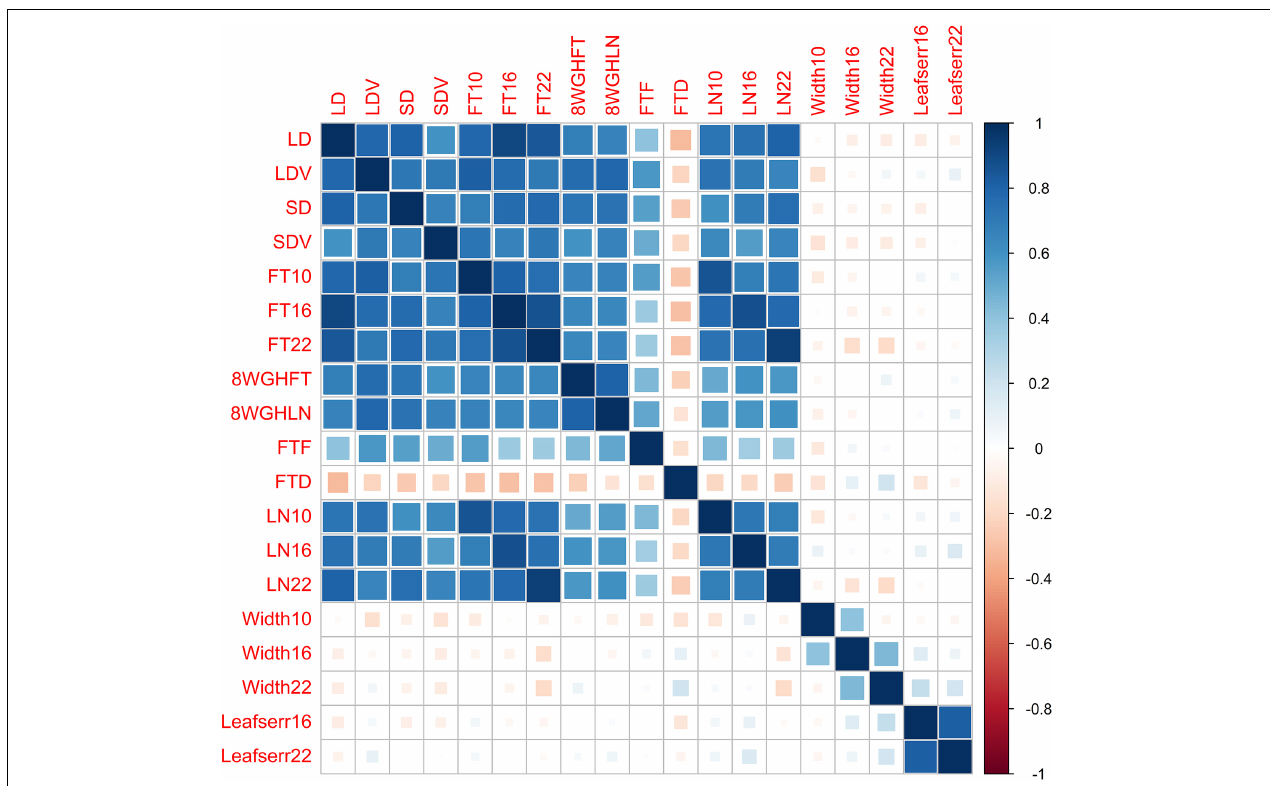
FIGURE 2 | Genetic correlations between 19 phenotypes in the Arabidopsis